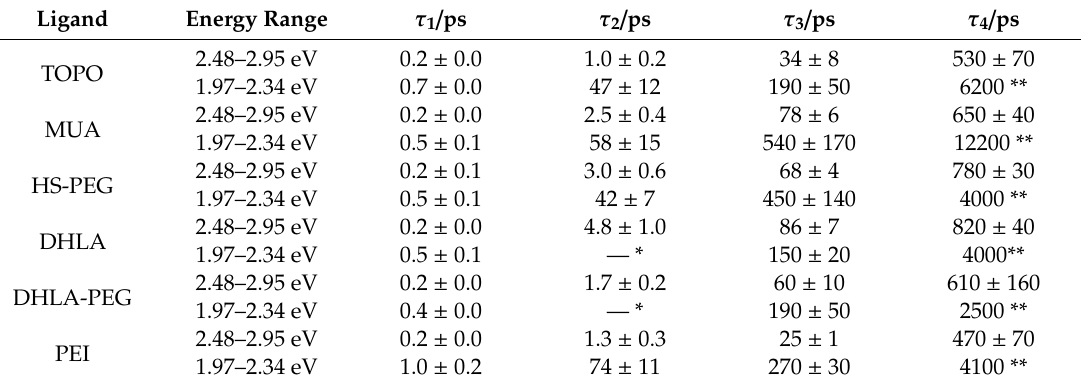
Table 3. Transient absorption spectroscopy on NR with di ff erent surface ligands. Time constants were obtained via a global fit within the indicated wavelength range. For the range 420–500 nm (indicating changes in excited CdS), four time constants and an o ff set were needed for all samples. For the range 530–630 nm (indicating changes in excited CdSe), two time constants and an o ff set were needed for DHLA- and DHLA-PEG-NR, and three and an o ff set for TOPO-NR, MUA-NR, and HS-PEG-NR, and PEI-NR. Ligand τ 1 / ps τ 2 /